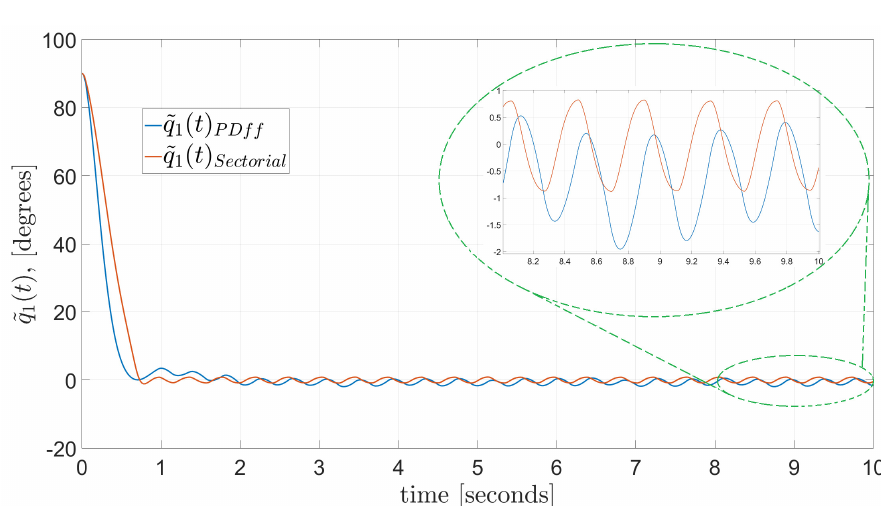
Figure 20. Desired vs. actual position in joint 2.